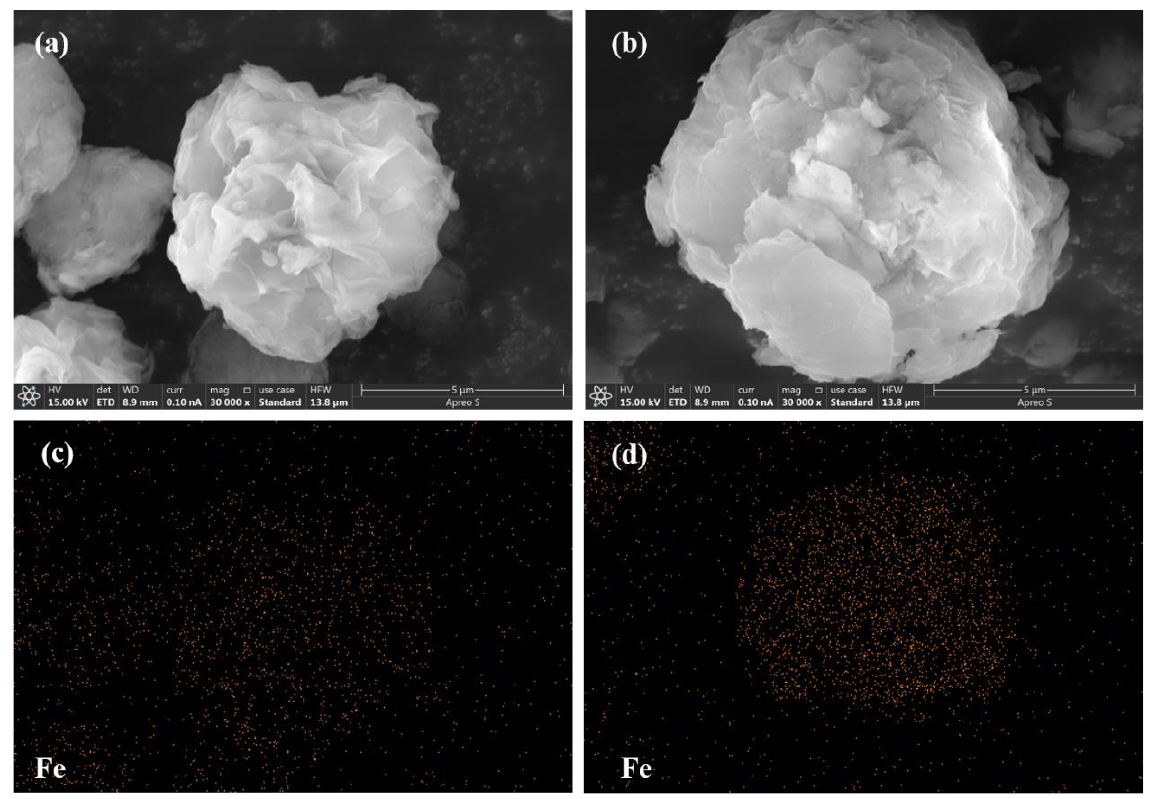
Figure 2. ( a ) SEM images of Na-MMT; ( b ) SEM images of Fe-MMT; ( c ) EDS images of Fe distribution in Na-MMT; ( d ) Fe distribution in